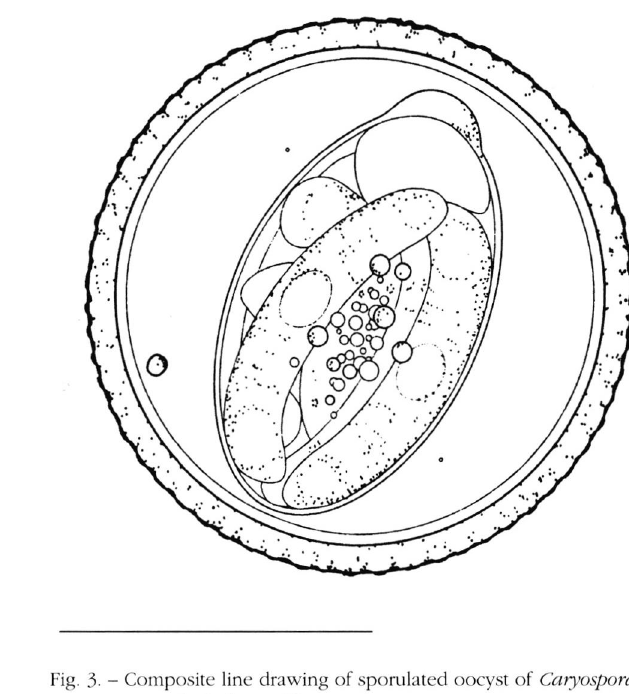
two barely distinguishable refractile bodies and cen­ trally located nucleus.